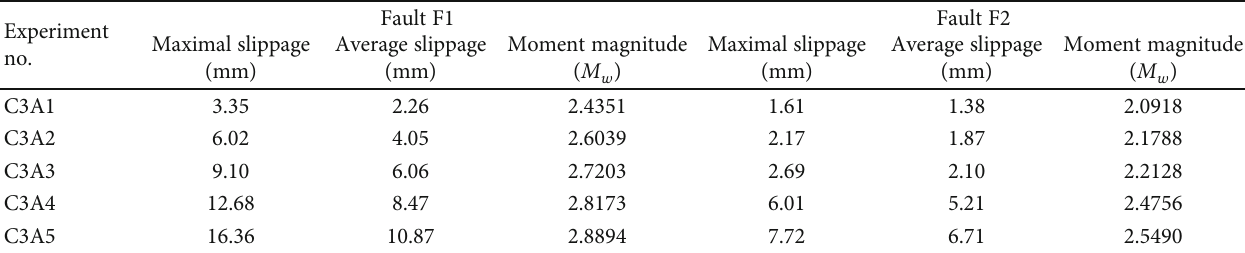
Table 11: The induced slippage and moment magnitude of fault F1 and F2 under the fracturing region area. Fault Experiment no.